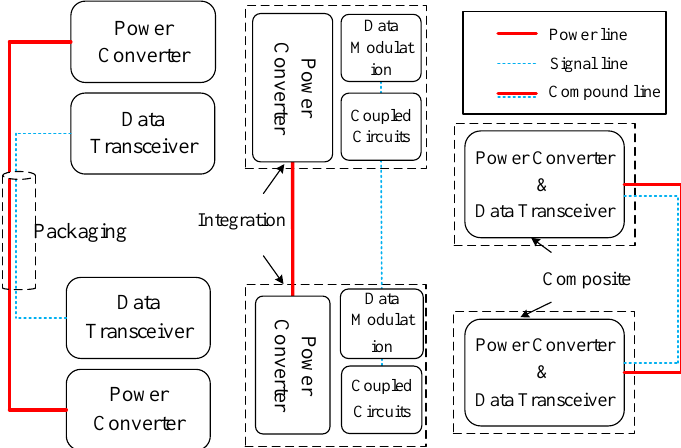
Figure 2. Schematic diagram of the development stage of compound communication technology.